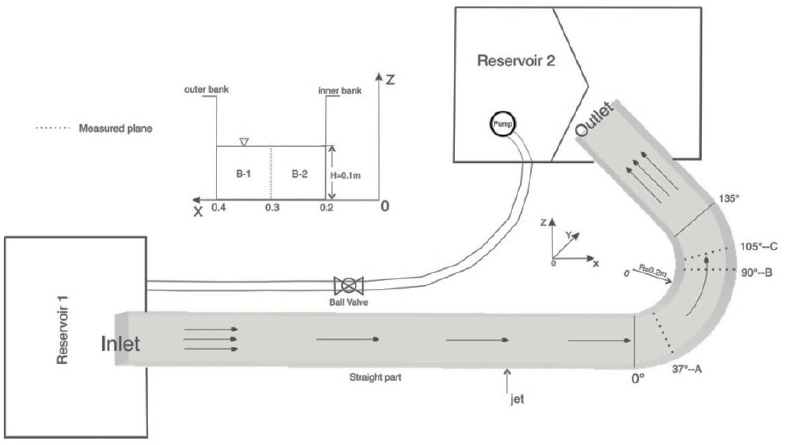
Figure 1. Sketch of the bend flume and the coordinate system with the flow condition in the flume.